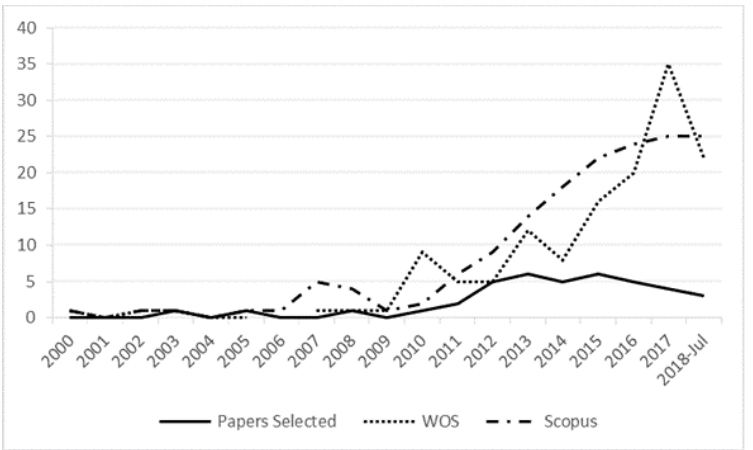
Figure 2. Distribution of the papers